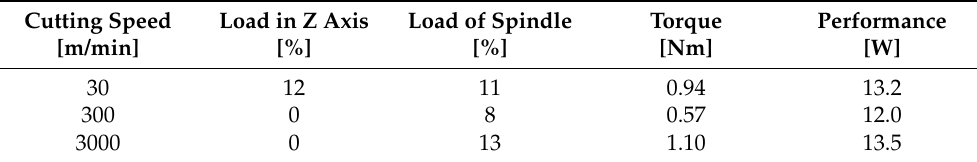
Table 4. Recorded values of observed parameters during machining of alumina.